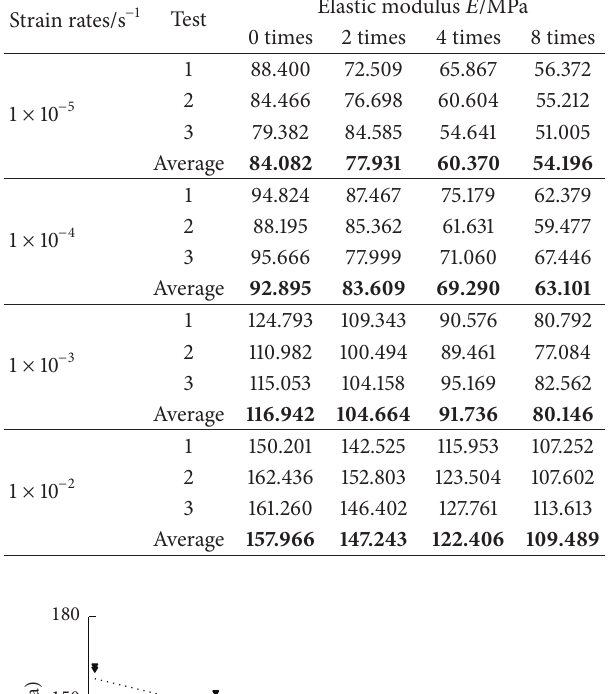
Table 3: Elasticity modulus of CA mortar under different drying and wetting cycle times.